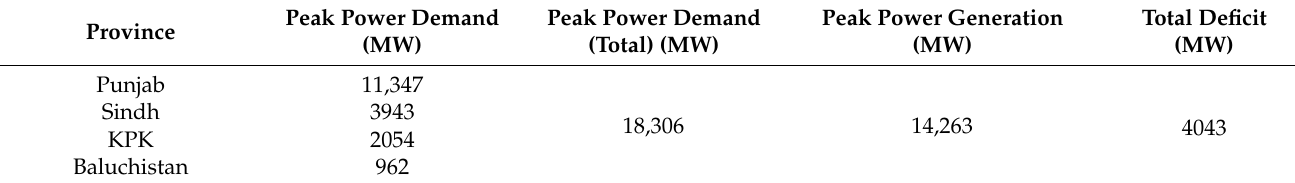
Table 1. Peak power demand, peak power generation and total power deficit of the four provinces of Pakistan.